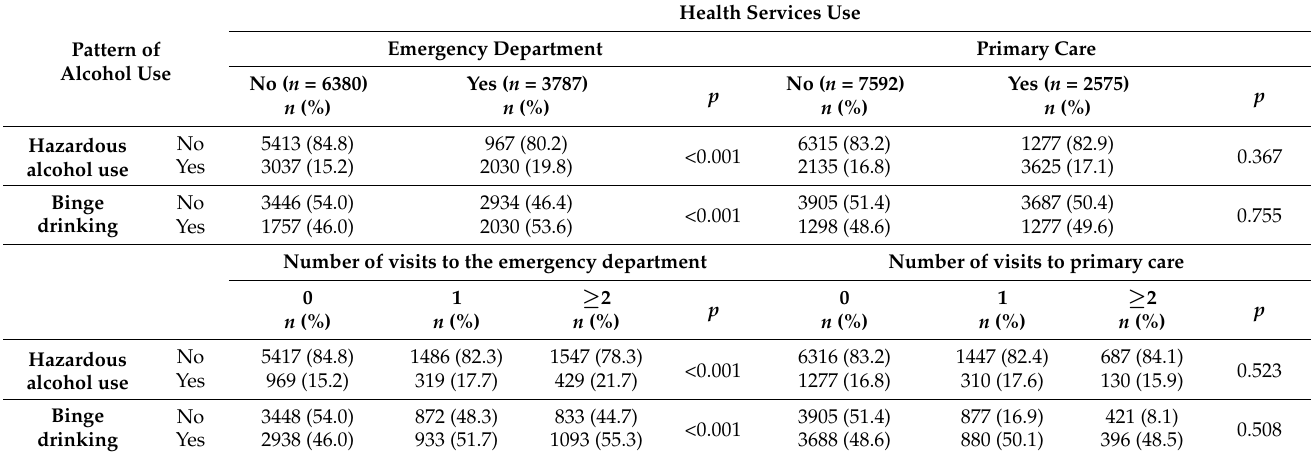
Table 3. Health services use among university students according to the pattern of alcohol